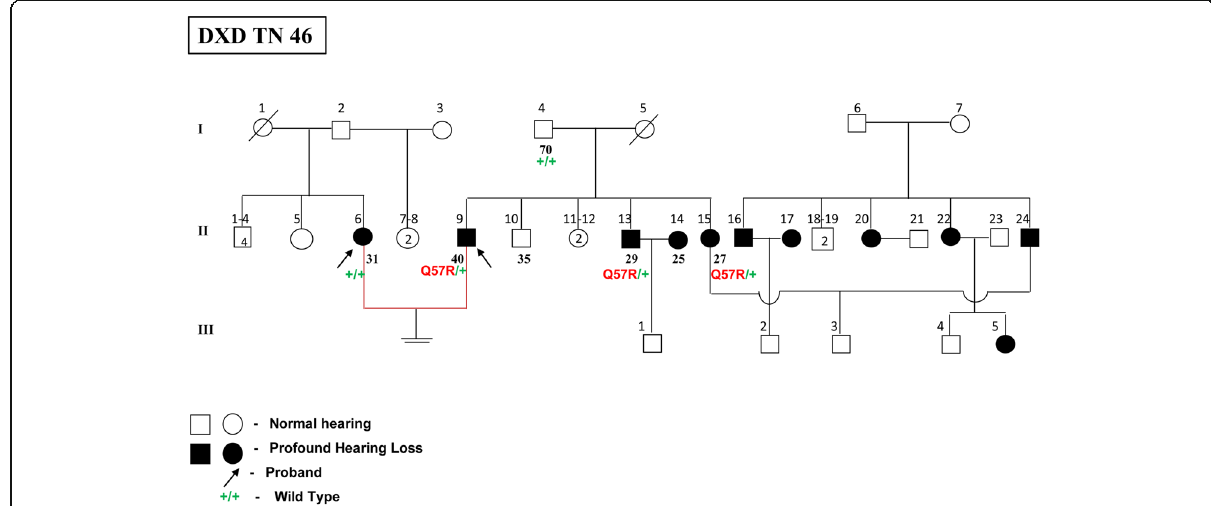
Fig. 4 Pedigree of DXD TN 46 family showing novel mutation p.Q57R in GJB6 gene